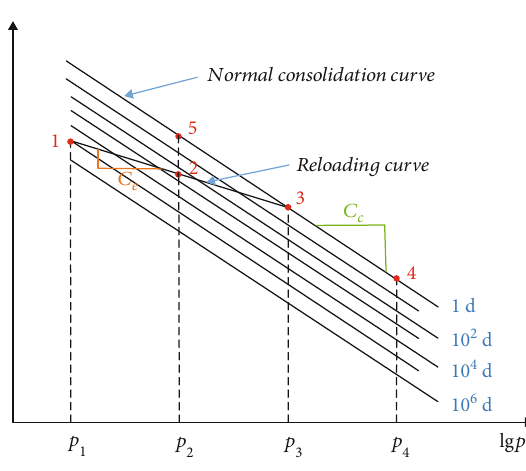
Figure 3: Equitime e − lg p